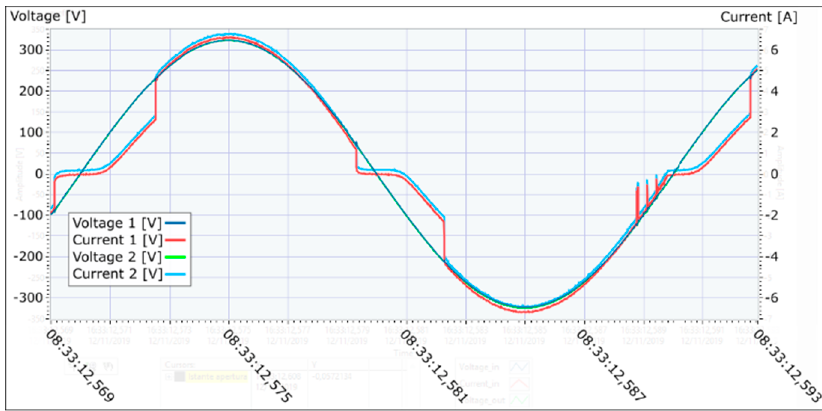
Figure 24. Deformation of the arc (using the Bourns 2049-30 surge arrester).